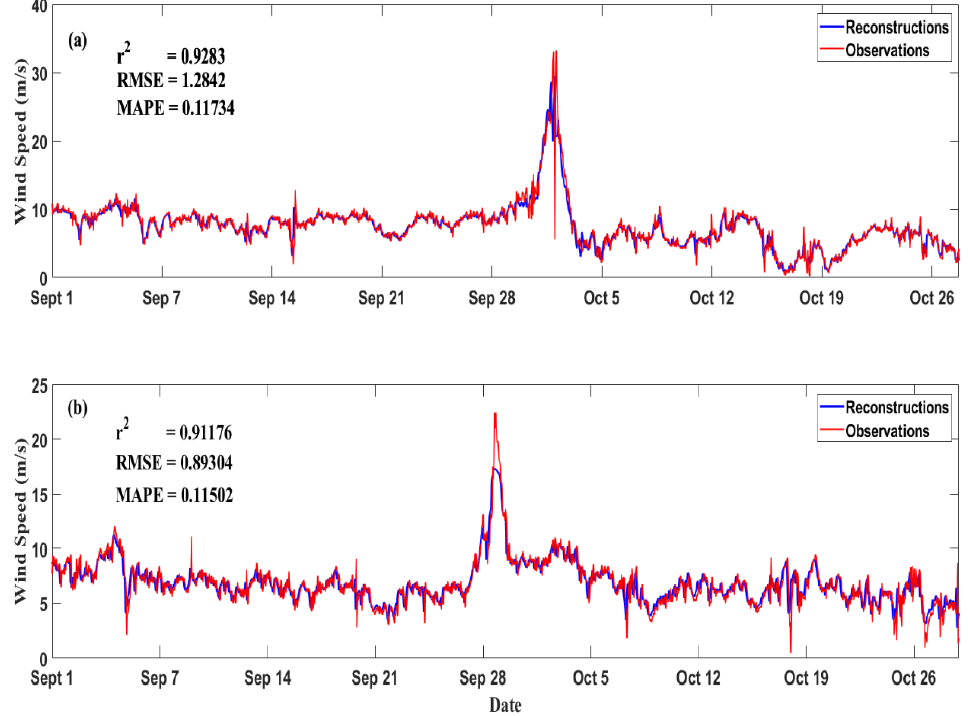
Figure 8. Comparison of reconstructed (blue) and observed (red) surface wind speed (m/s) at NDBC buoy 42058 ( a ) and 42059 ( b ) before, during, and after the passage of Hurricane Matthew (2016).